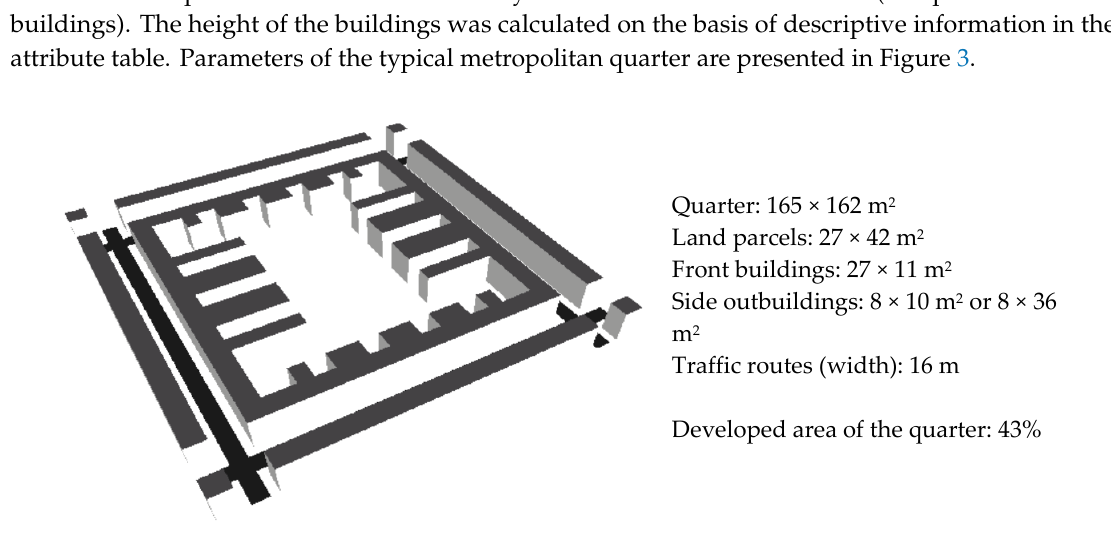
Figure 3. Parameters of a typical inner-city quarter in Lodz.